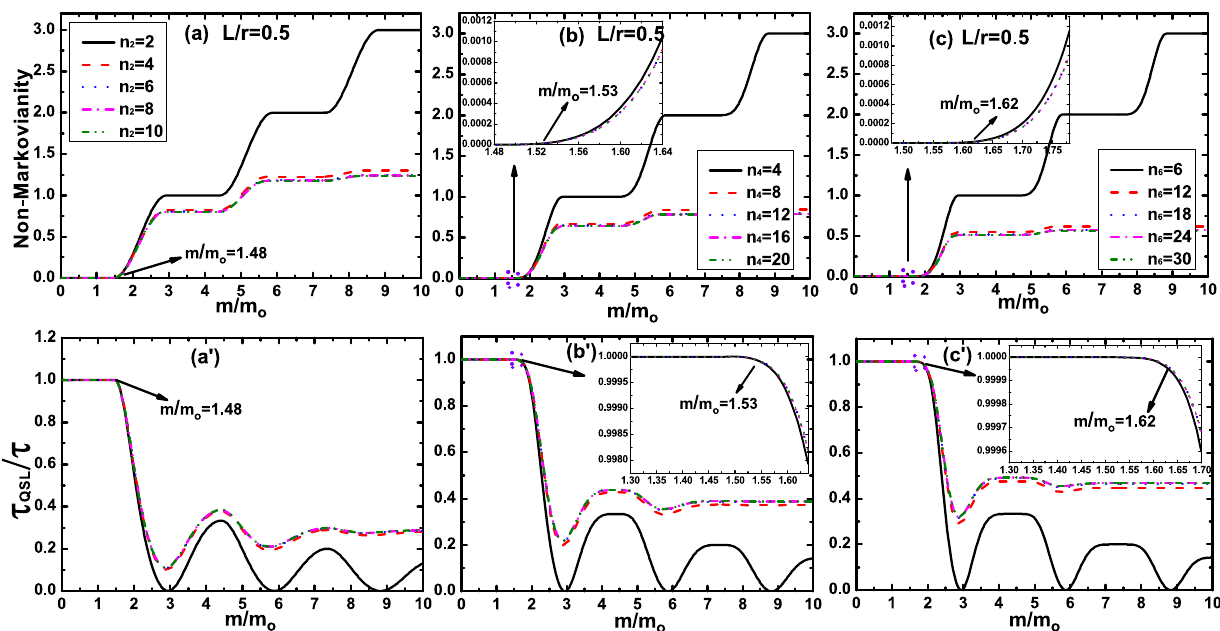
Fig. 5 For the two dimensional even ray case ( x = 2, x = 4 and x = 6), and the actual evolution time τ = 0 . 4s, r =250 µ m, L = 0 . 5 r and m o =10 − 13 kg. a – c Non-Markovianity N (ϕ) of the dynamics pro- cess of the system particle m o as a function of m / m o with differ- ent number of the environment particles n x . a (cid:2) – c (cid:2) The QSLT for the